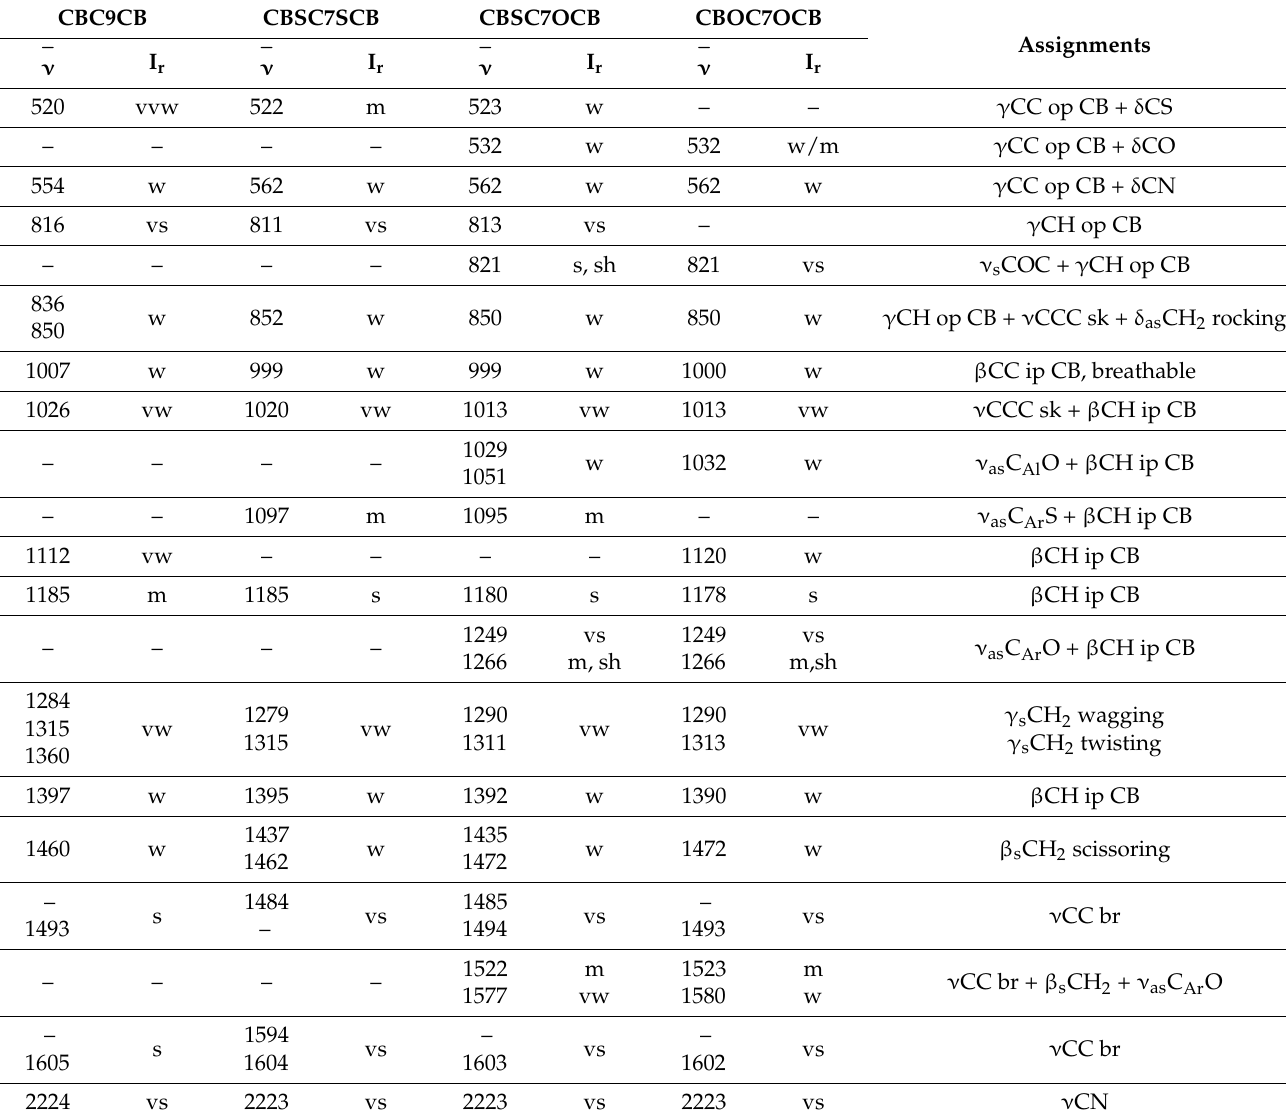
Table 2. Vibrational frequencies, IR intensities and assignments of the